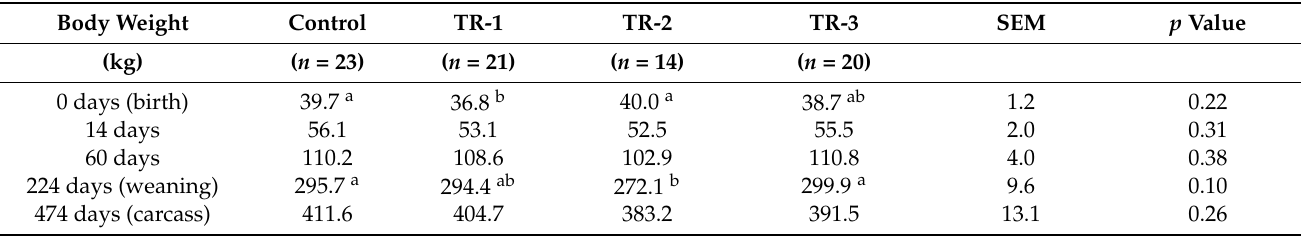
Table 1. Postpartum body weights and hot carcass weights (kg; LSmean) for calves from control dams and from dams supplemented with Se-yeast boluses (105 mg Se/wk) during the first (TR-1), second (TR-2), and third (TR-3) trimester of